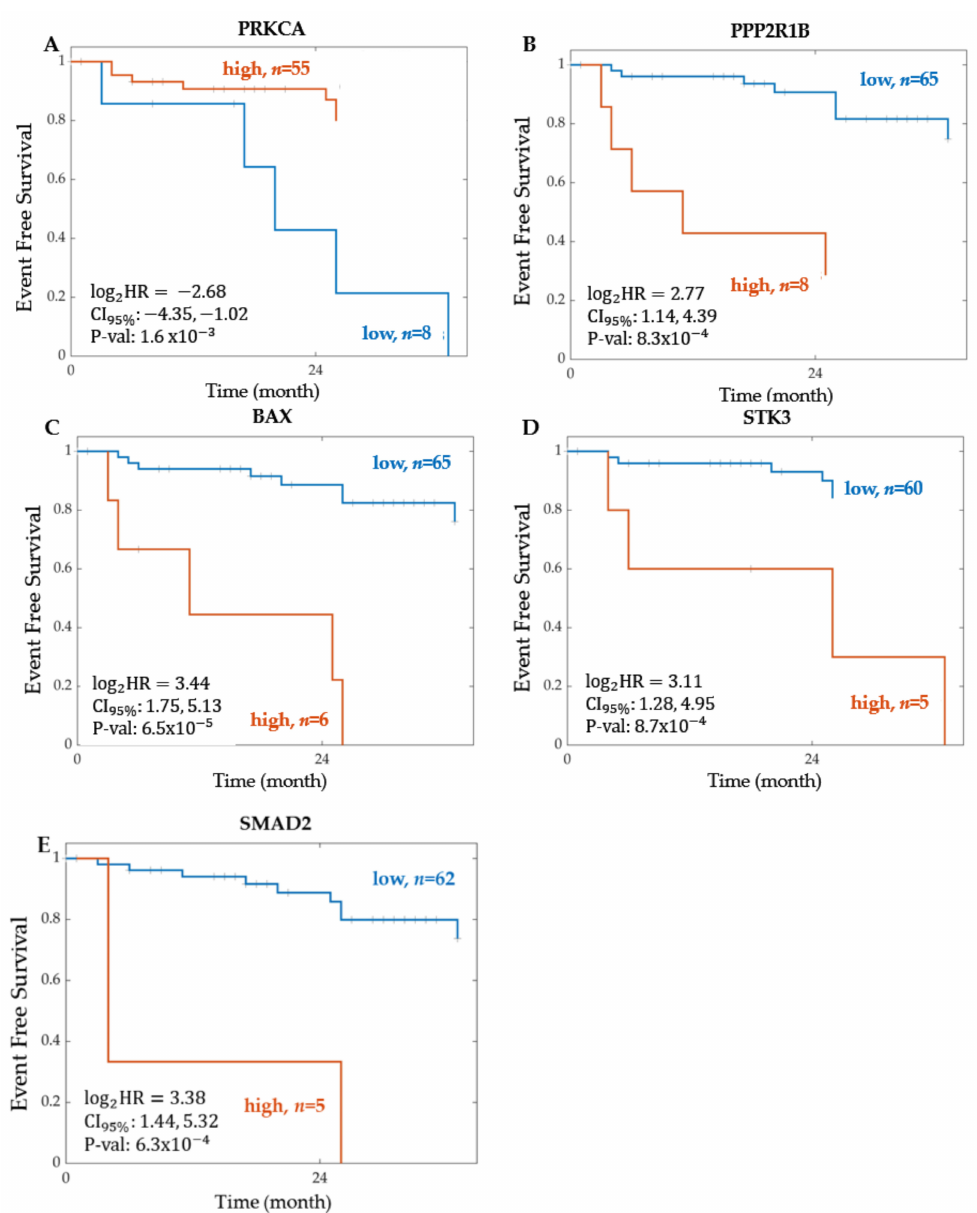
Figure 5. Kaplan–Meier curve of event-free survival for the most significant protein, of each CRC STN. The most significant protein in each signalling pathway from the proteomics TCGA Firehose legacy dataset was ( A ) PRKCA for WNT STN, ( B ) PPP2R1B for PI3K-Akt STN, ( C ) BAX for TP53 STN, ( D ) STK3 for MAPK STN, and ( E ) SMAD2 for TGF-Beta STN. The patients were stratified into two groups according to the expression level of each feature. The optimal cut-off was determined using Kaplan–Meier scanning (see Methods). The groups are represented as high (orange line), and low (blue line), where n indicates the total number of patients in each group. For each group, the Kaplan–Meier curve of event-free survival was tested for statistically significant differences using a log-rank test. Log HR = log base 2 of the hazard ratio. CI 95% = 95% Confidence Interval. 2 P-val = p